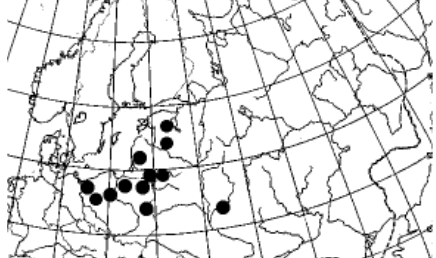
Fig. 4. Distribution of Sarcosagium campestre in Eastern and East Central Europe (cid:3) modern records